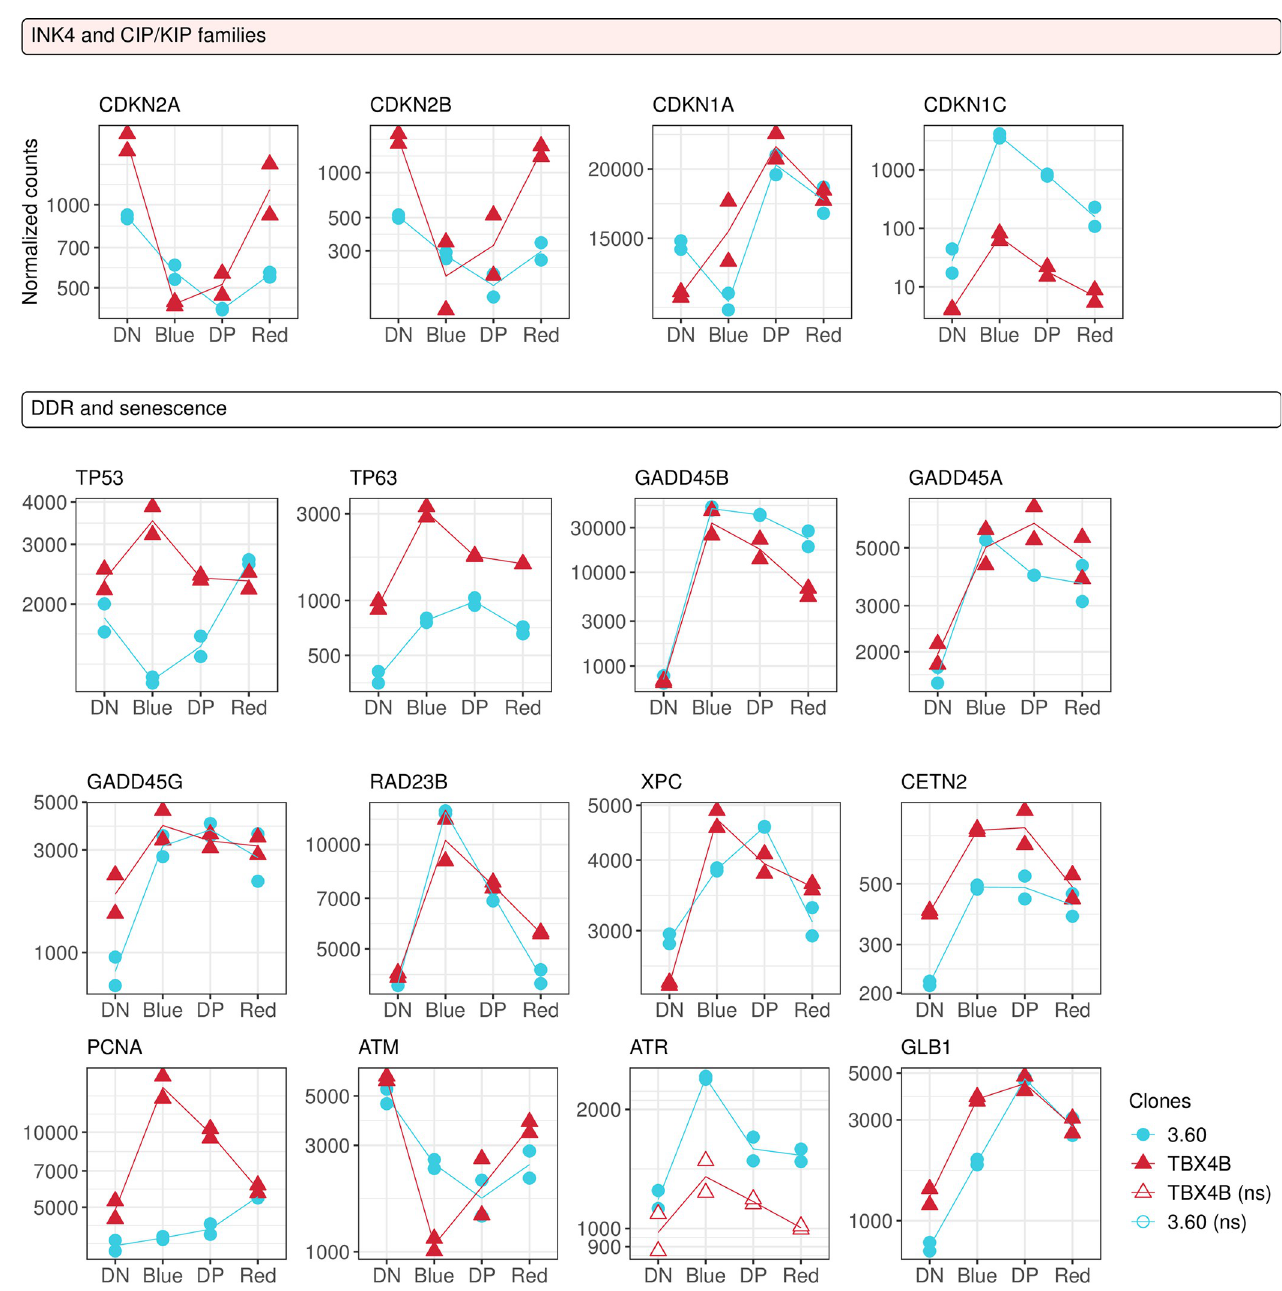
Fig 5. Up-regulation of DNA damage response and senescence markers. Gene expression trajectories of cell cycle inhibitors, DNA damage response genes and senescence markers. Y-axis: normalized counts on log 10 -scale. Statistical significance was determined by LRT. FDR-corrected p-value < 0.01; ns—not